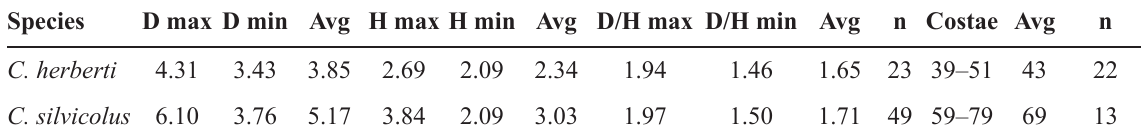
Table 2. Measurements of Chondrocyclus herberti sp. nov. and C. silvicolus sp. nov., showing differences between the species; D = shell diameter, H = height, costae = number of axial ribs on body whorl, avg =